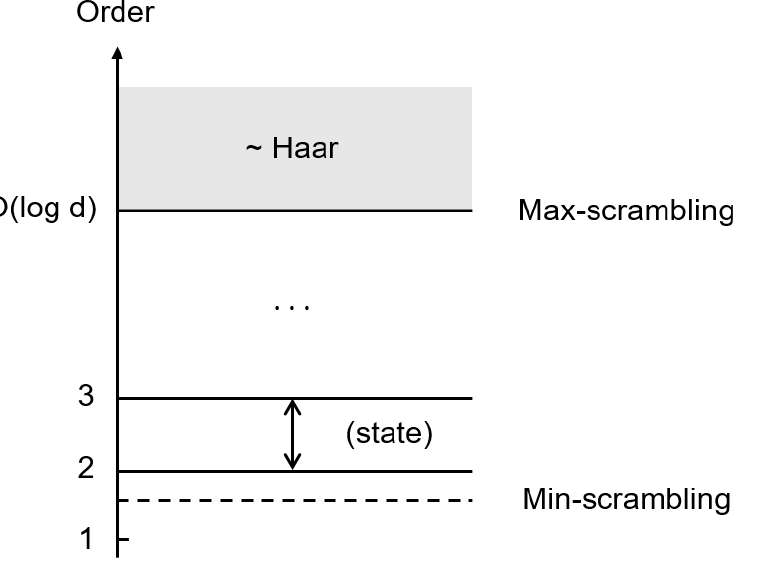
Figure 2 . The hierarchy of entropic scrambling complexities. Each order is given by near- maximality of corresponding R(cid:19)enyi entanglement entropies, which diagnose the complexity of cor- responding designs. The highest such complexity, corresponding to the notion of max-scrambling, is achieved at an order that roughly scales logarithmically in the dimension of the system. The weakest form of scrambling, or min-scrambling, is weaker than order-2 but stronger than order-1. Order-2 is strictly separated from higher orders in the state